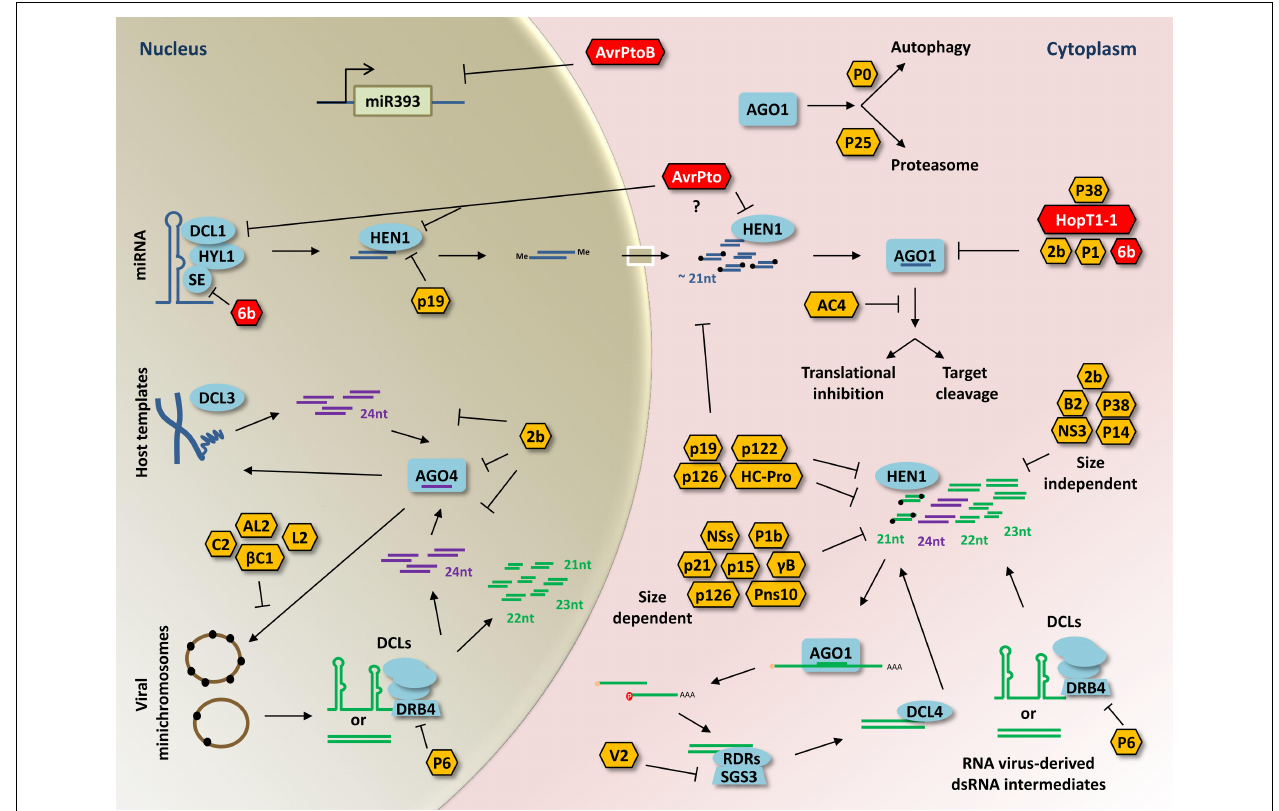
interacts with the SGS3 factor and avoids sRNA amplification.The P6 protein affects production of DCL4-dependent sRNAs by interacting with DRB4. SomeVSRs (P122, HC-Pro, P19, P126) have been reported to inhibit 3 (cid:2) methylation of sRNAs probably by sequestering double-stranded sRNAs and/or arresting HEN1 methylation. Similar to BSRs, viral suppressors (P38, 2b, P1) interact directly with AGO1.The AC4 protein suppress PTGS by binding only single-stranded sRNAs. For DNA viruses (pararetroviruses or geminiviruses) that accumulate as minichromosomes in the nucleus (brown circles), methylation-mediated transcriptional gene silencing is affected by several viral suppressors ( β C1, C2, AL2, L2, 2b). Another major strategy employed byVSRs consists on sequestering sRNAs with a specific (size-dependent) or unspecific (size-independent) nucleotide length. Furthermore, P0 and P25 promote AGO1 degradation through autophagy and proteasome-dependent degradation, respectively. Small RNA binding and disturbance or inhibition of small RNA silencing factors are indicated (perpendicular